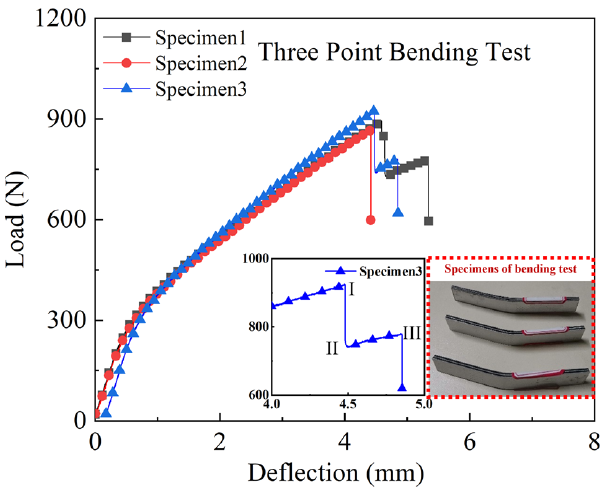
Figure 16. Load versus deflection curves of the three-point bending tests on the CARALL.